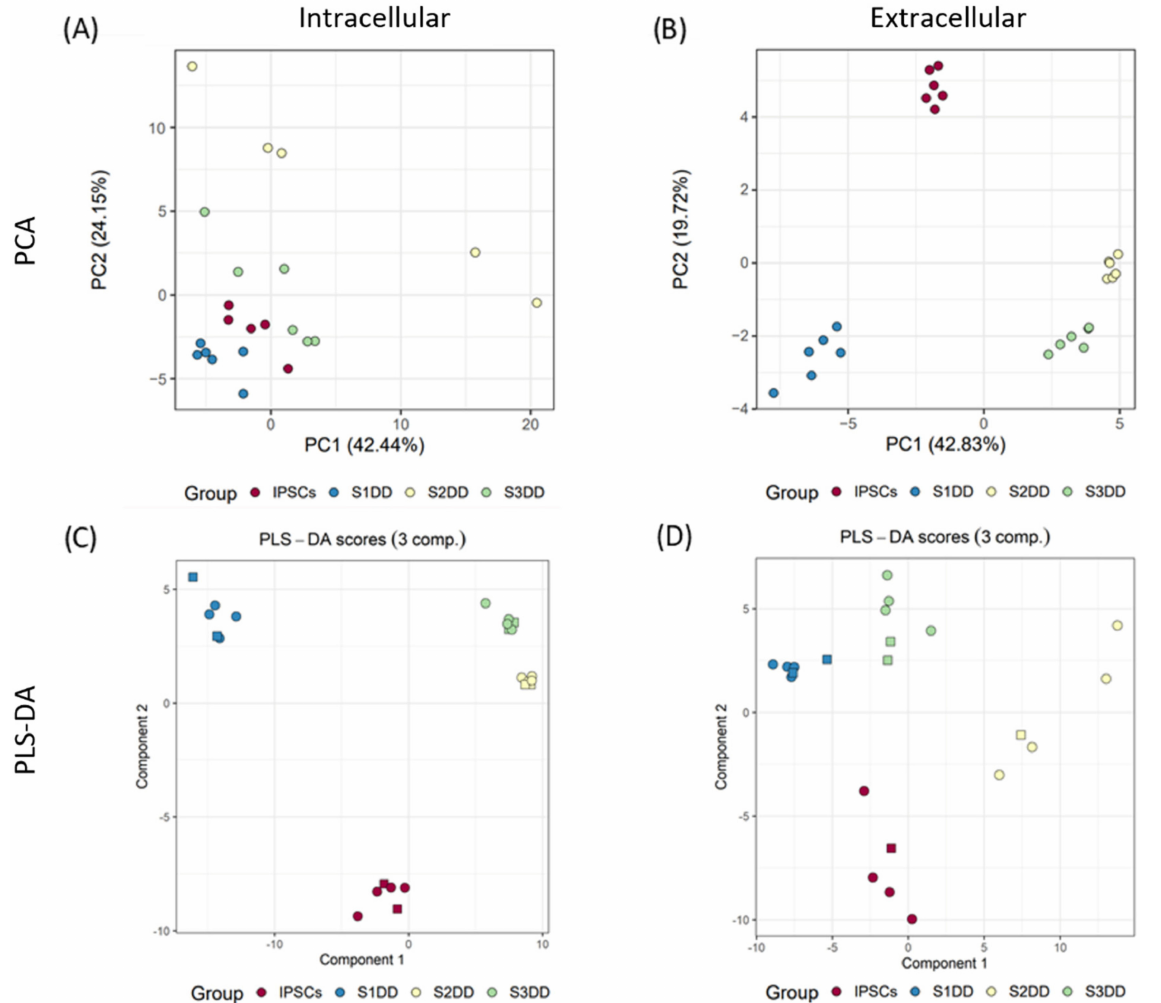
Figure 3. Multivariate analysis of intracellular and extracellular metabolites for pluripotent and directed differentiation Stage 1, 2 and 3. Unsupervised PCAs for intracellular ( A ) and extracellular ( B ) metabolites. Supervised PLS-DA for intracellular ( C ) and extracellular ( D ) metabolites. Circles or squares indicate the split of data between training and testing, respectively, for predictive PLS- DA